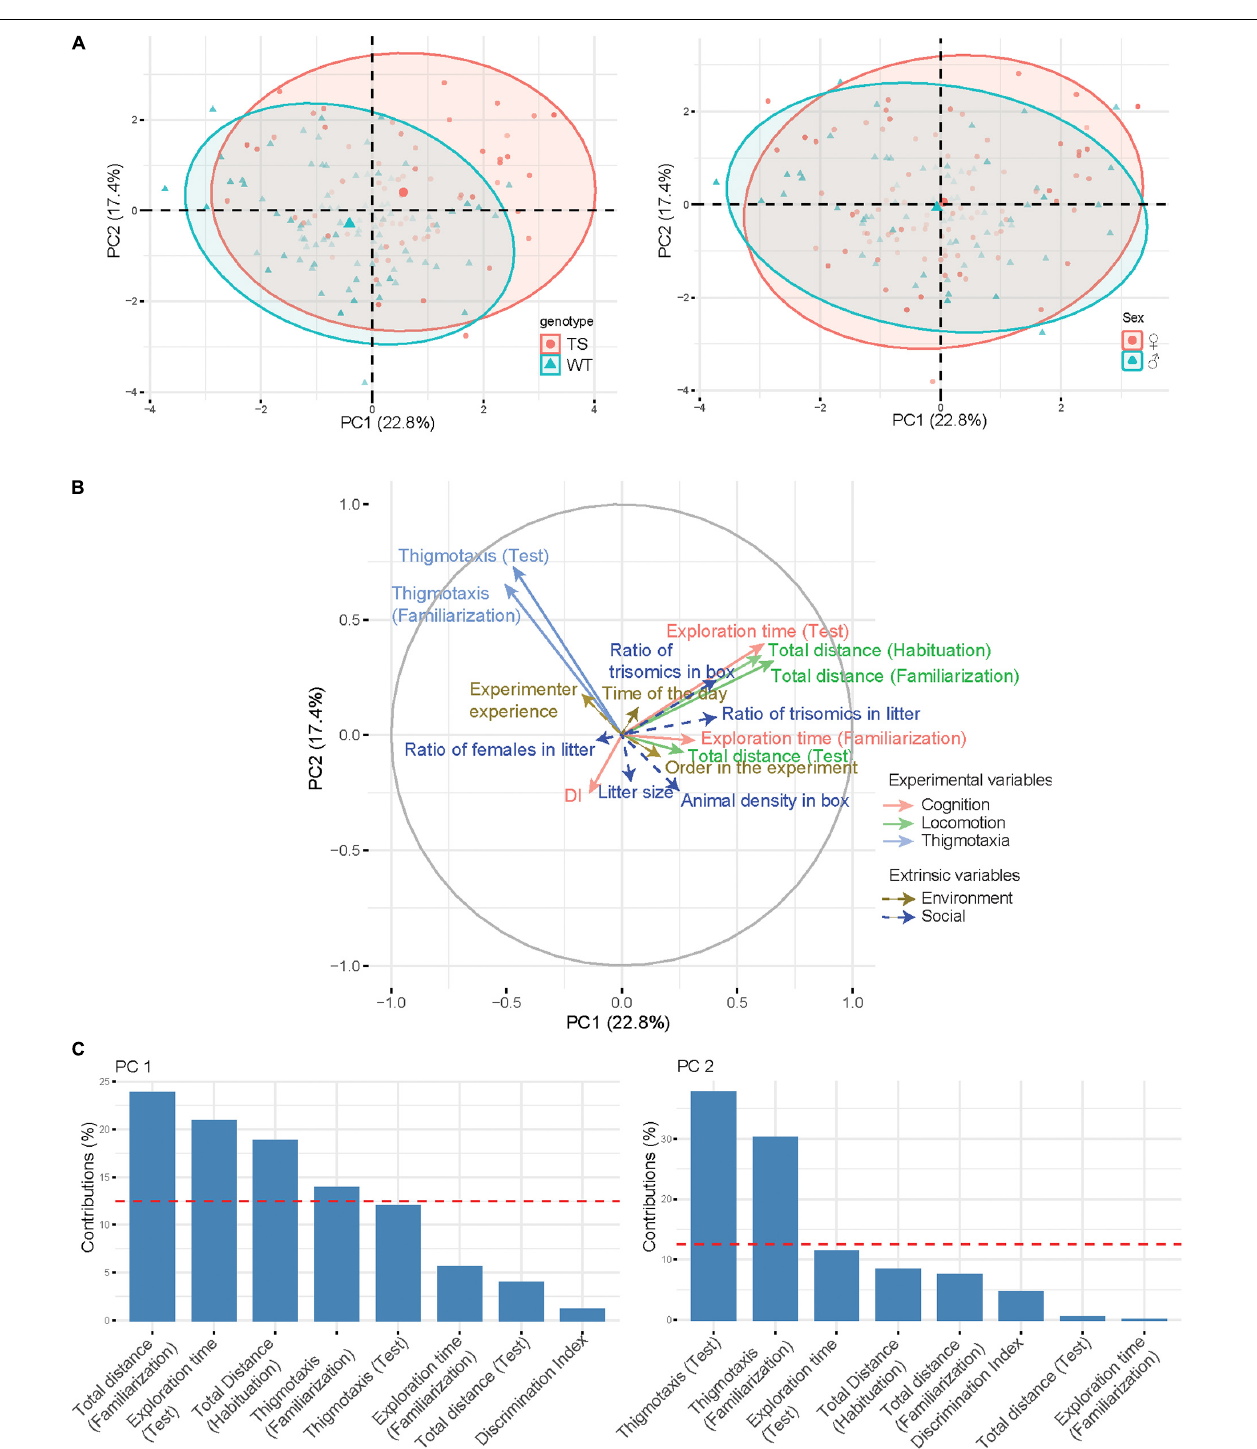
FIGURE 2 | Principal component analysis. (A) PCA plotting the first two components (respectively, x-axis and y-axis). Points are plotted according to the genotype (left) or sex (right) and with the color intensity proportional to the importance of a principal component for a given observation (square cosine). Ellipses and their centroid are drawn for each group to show the direction of the separation on the axes. (B) Graph of variables along with the PCA plot. The variables used for the computation of the PCA are solid arrows, while supplementary variables are represented with dashed arrows. (C) . Barplot of variable contributions (loadings) for the first two principal components. A reference red dashed line is also shown on the barplot. This reference line corresponds to the expected value if the contribution were uniform.